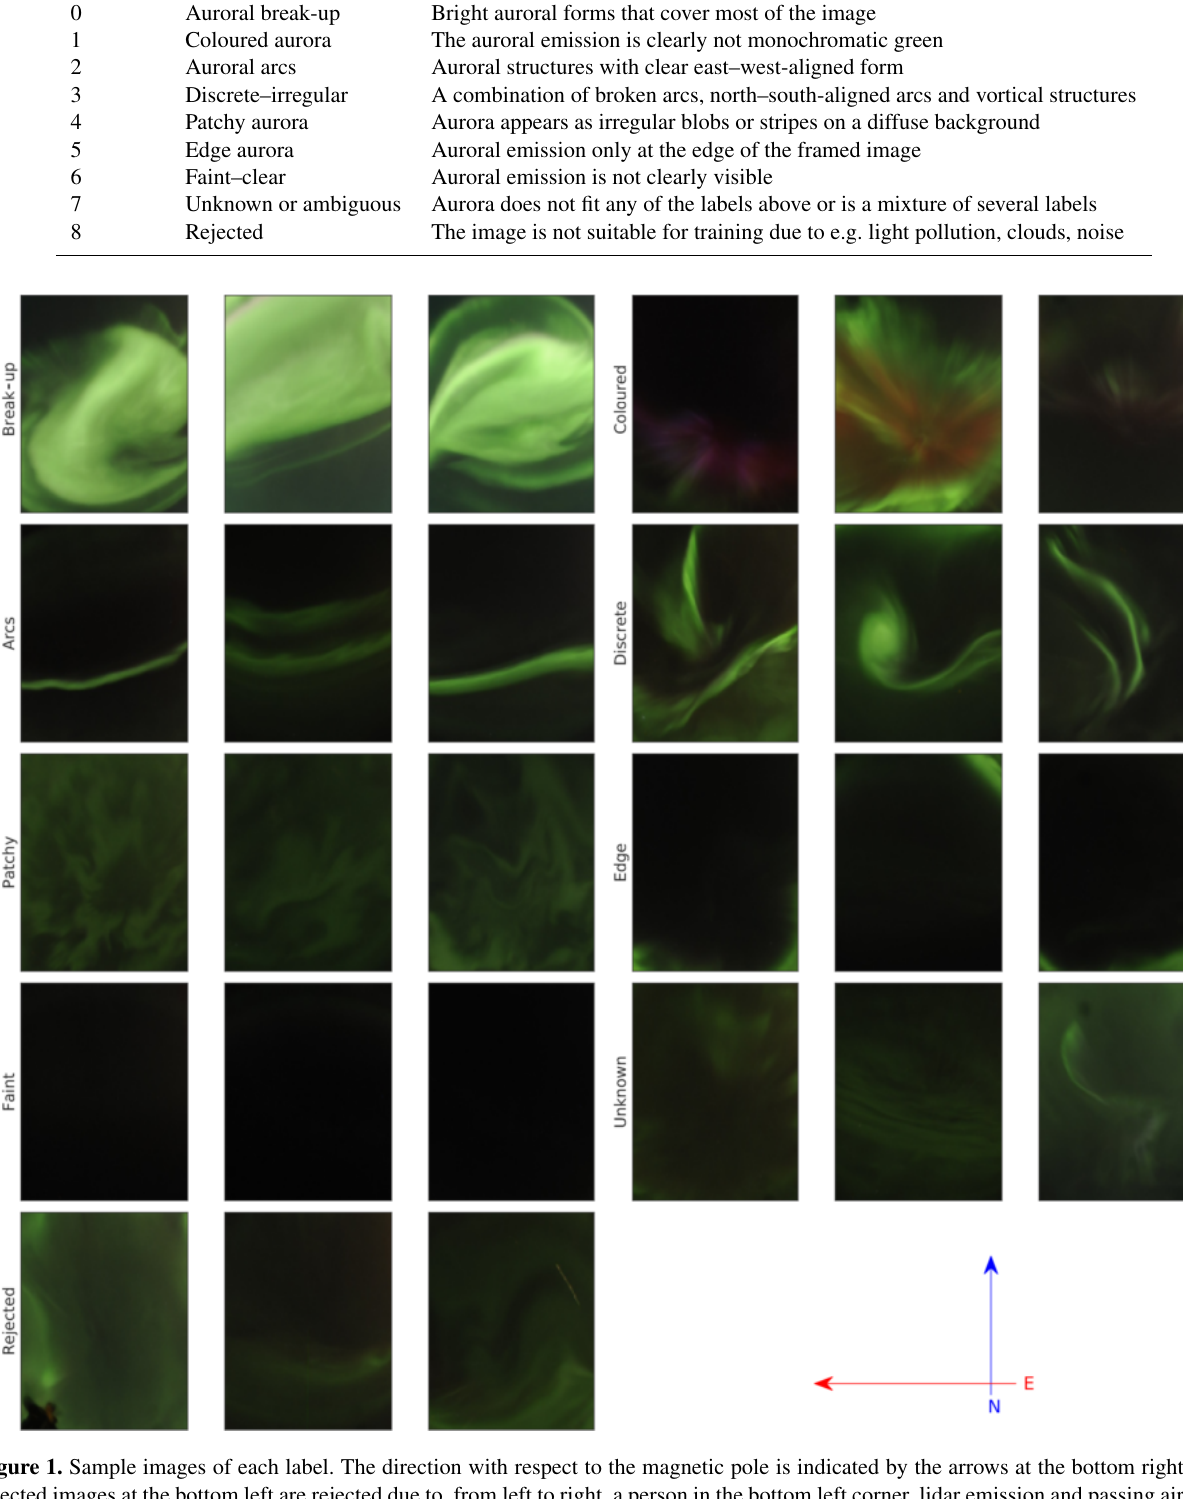
Table 1. The set of aurora labels used for the classification run. Label no.